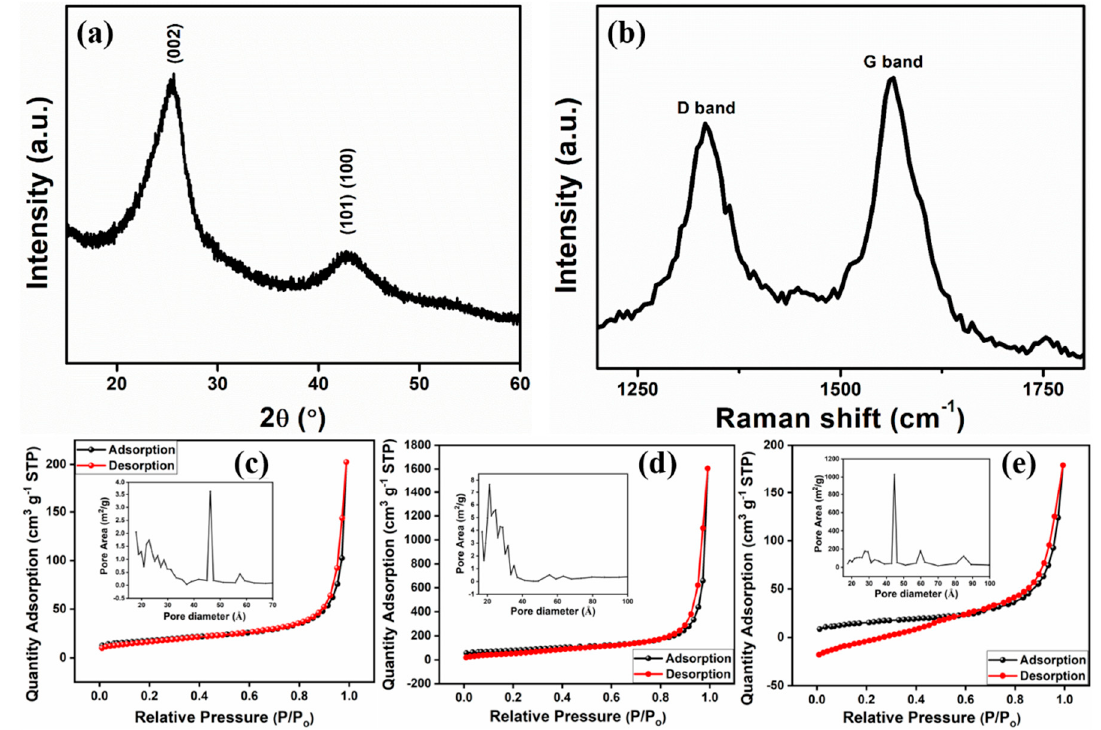
Figure 4. ( a , b ) The typical XRD and Raman analyses of the MWCNTs/AC/BNNTs ternary composite material, respectively. ( c – e ) N 2 adsorption–desorption isotherms (inset show pore size distribution) of the MWCNTs, activated carbon and BNNTs, respectively.